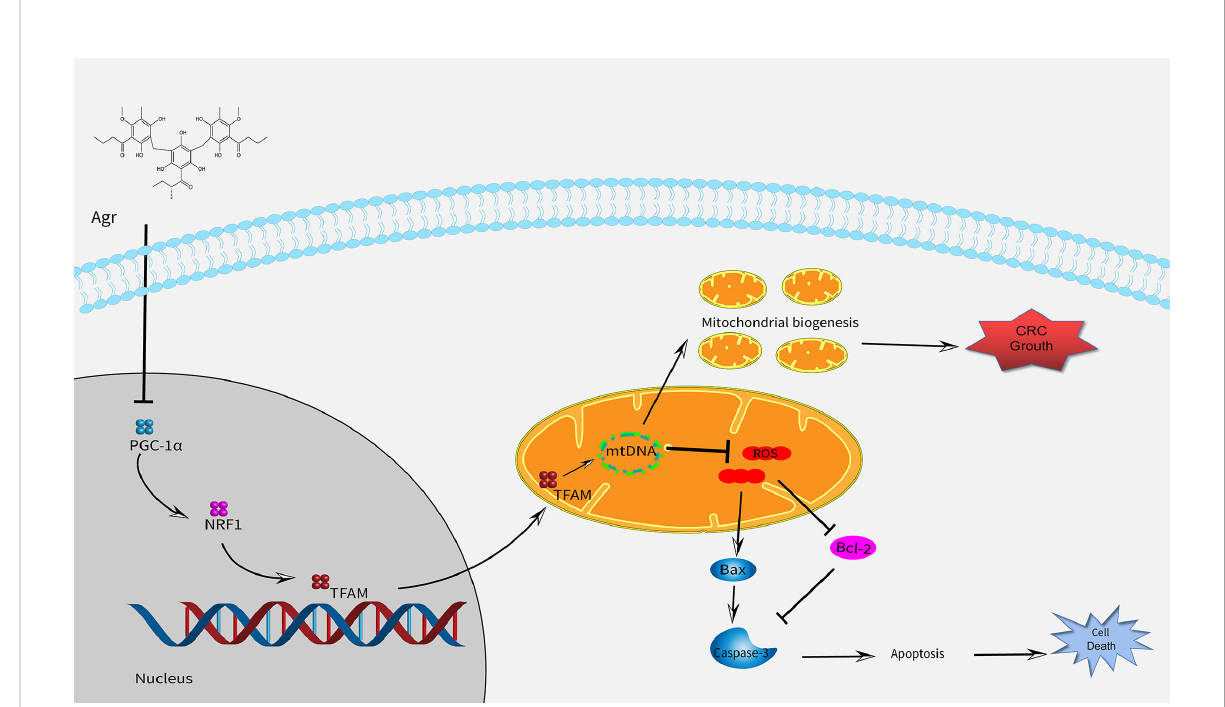
FIGURE 8 A schematic model showing that Agr alters mitochondrial biogenesis and can cause cell death by decreasing the expression of PGC-1 a /NRF1/ TFAM. Agr, agrimol (B); PGC-1 a , peroxisome proliferator-activated receptor- g coactivator 1 a ; NRF1, nuclear respiratory factor 1; TFAM, mitochondria transcription factor